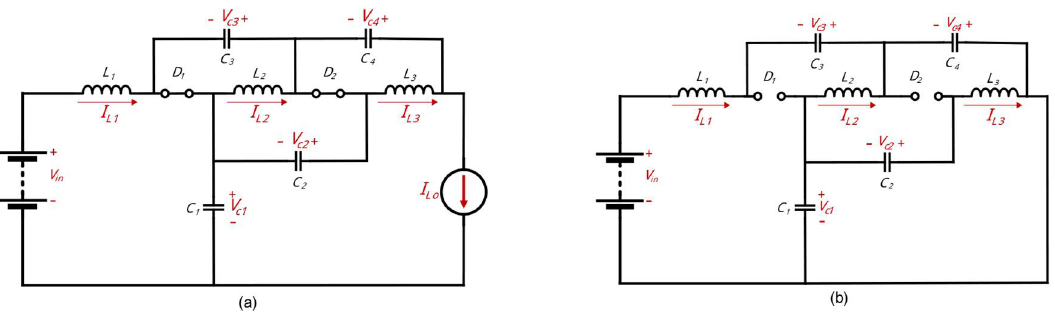
Figure 2. ( a ) Non-Shoot Through State; ( b ) Shoot Through State.